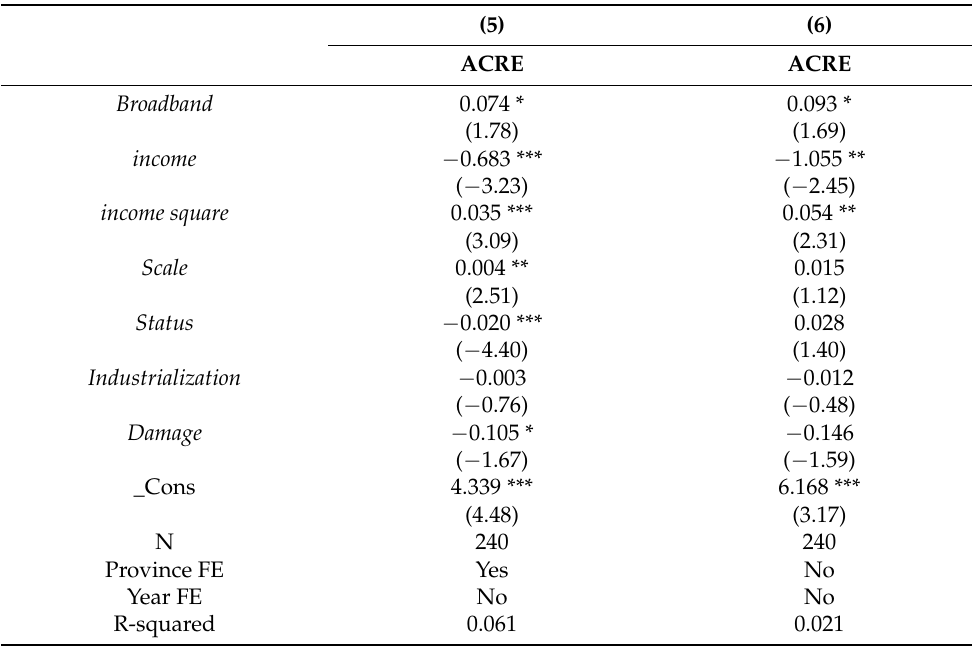
Table 6. Endogeneity problem: The independent variable lag for one